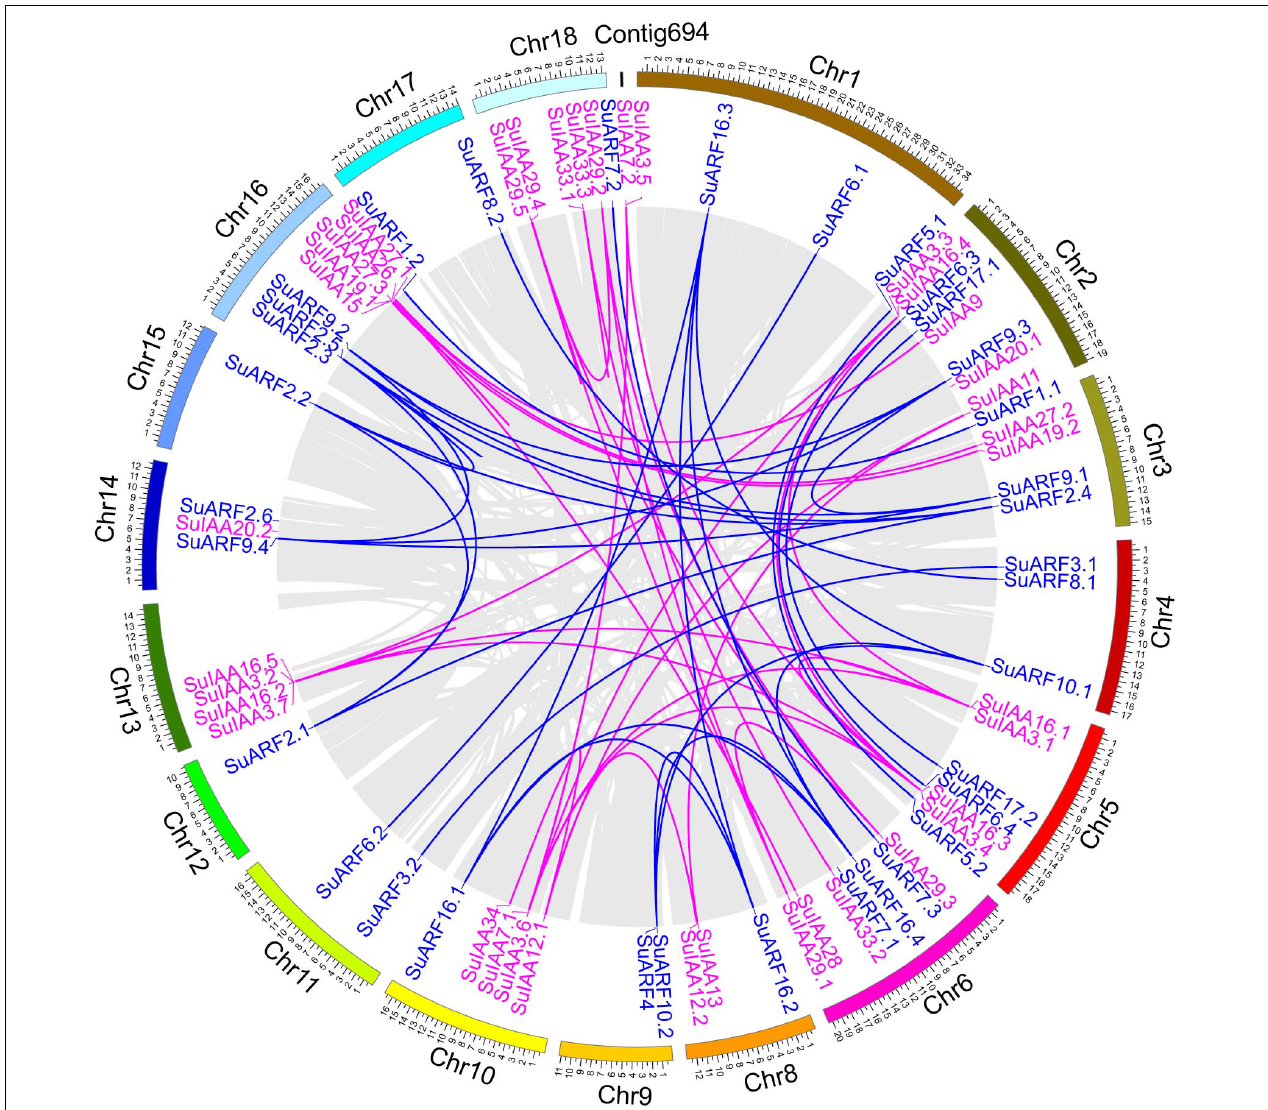
FIGURE 1 | Genomic distribution of SuIAA and SuARF genes on the Salix suchowensis genome. The SuIAA genes and SuARF genes on each chromosome are plotted in purple and blue, respectively. Gray ribbons indicate collinear relationships among the blocks in whole genome; meanwhile, purple and blue links indicate the syntenic pairs of SuIAA genes and SuARF genes, respectively. The willow chromosomes and Contig694 are arranged with arcs with different colors, and the size of each arc is displayed in Mb.